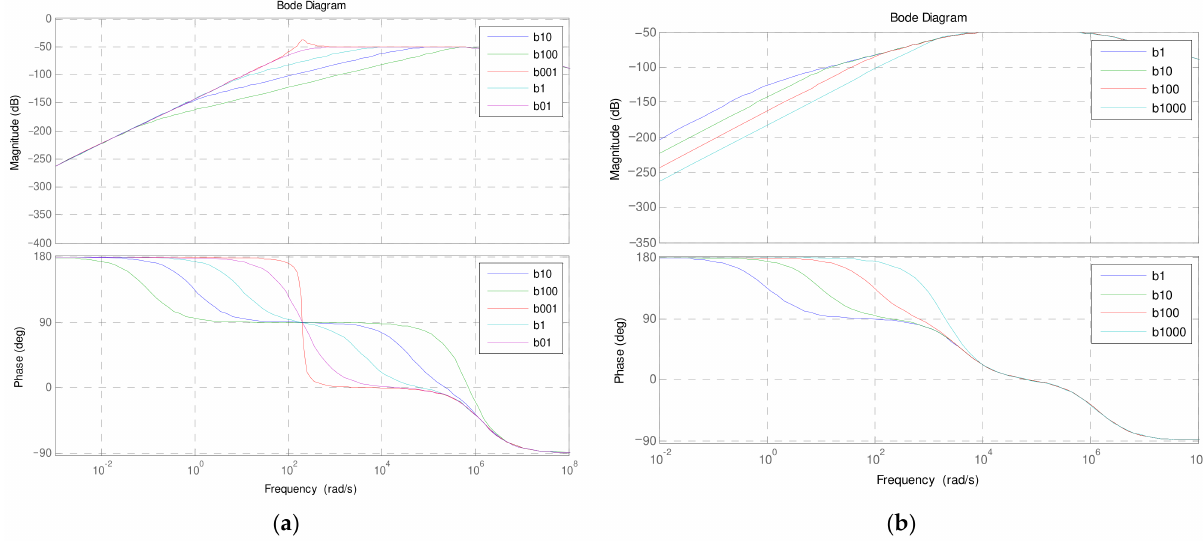
Figure 8. The frequency response curves of Z ( s ) corresponding to different parameters. ( a ) The curves corresponding to different K vp . ( b ) The curves corresponding to different K vi